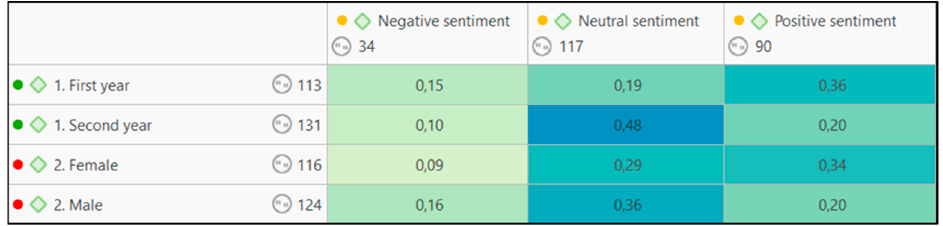
Figure 4. Table of co-occurrence between sentiment analysis codes and sociodemographic codes.